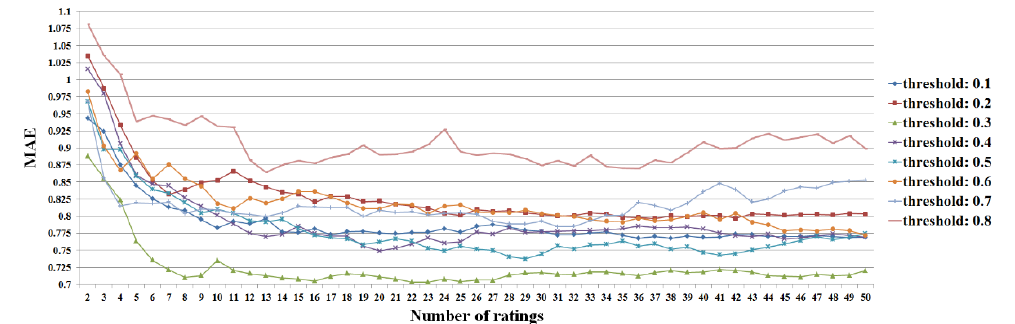
Figure 22. Mean absolute error (MAE) values for the different numbers of ratings based on the Pearson correlation coefficient in the user-based filtering.